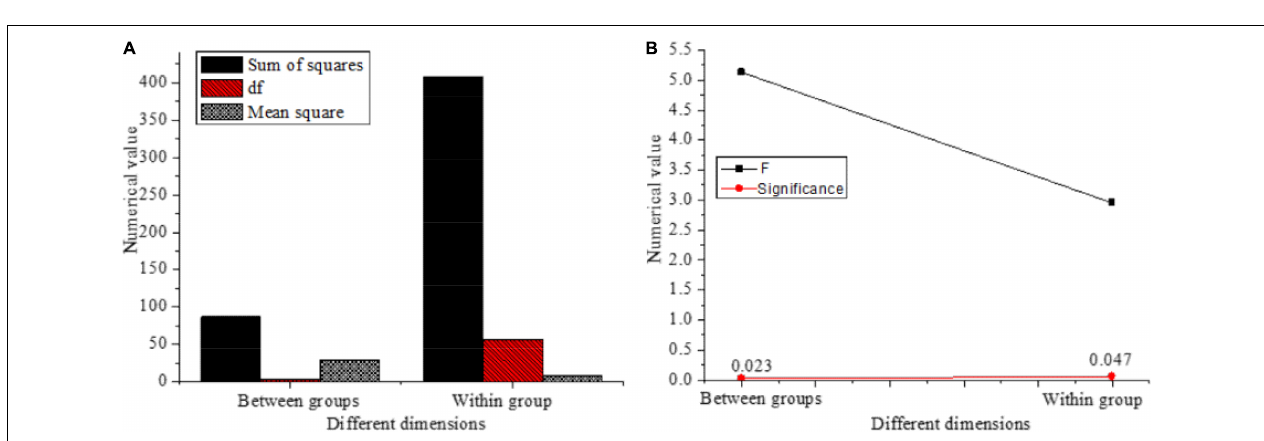
FIGURE 9 | Influence of the ages of entrepreneurs on different variables. (A) t -test results of the mean equation of different variables affected by entrepreneur age. (B) Levene test results of the variance equation of different variables affected by entrepreneur